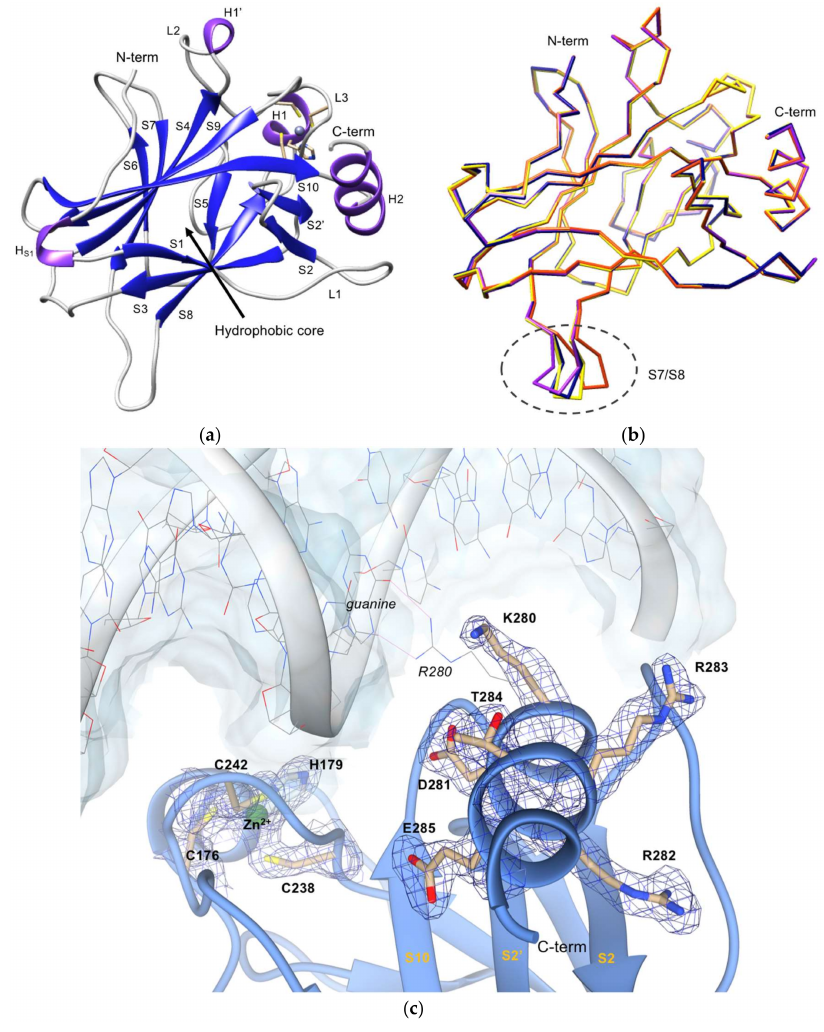
Figure 1. Crystal structure of p53R280K DBD. ( a ) Ribbon diagram of p53R280K DBD; strands are shown in dark blue, helices in purple, linked by gray coils. The zinc(II) ion is represented by a gray sphere near L3 loop and H1 helix and its coordinating amino acid residues (C176, H179, C238, C242) are shown as yellow sticks. ( b ) Backbone superposition of the four molecules of p53R280K DBD in the asymmetric unit of the crystals. Molecule A, purple; molecule B, yellow; molecule C, blue; molecule D, orange. Encircled by a gray dashed line is the region with the highest structural variation, the S7/S8 turn. ( c ) Electron density map calculated around the C-terminus residues and the zinc(II) ion, in green (2mF o -DF c map at 1 σ level and 2 Å resolution). The p53R280K DBD polypeptide chain is represented in blue ribbon. Clear electron density for the lysine residue at position 280 is seen in all molecules of the asymmetric unit in the p53R280K DBD domain structure. The DNA fragment and the arginine residue of the wt form (PDB code 2AC0) are superposed to illustrate the orientation of the protein in relation to the DNA and are depicted in color-coded wire-frame and labeled in italic. The two direct hydrogen contacts with guanine, that are disrupted in the p53R280K structure, are depicted as pink thin lines. Residues from p53R280K are labeled in bold, while residues in the wt complex are labeled in